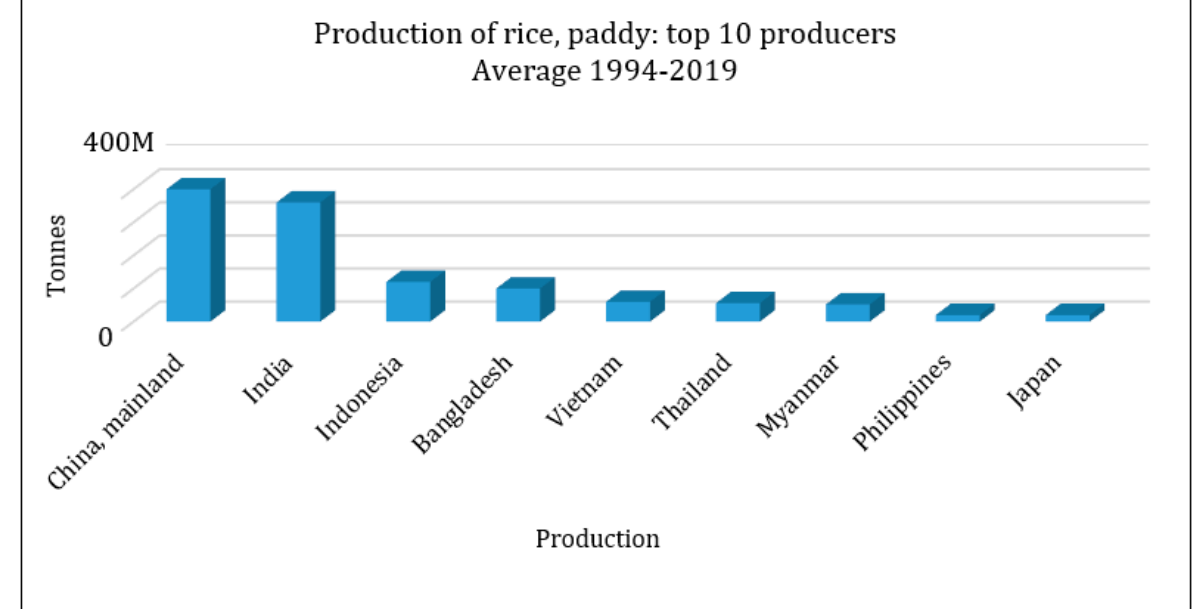
Figure 2. Major rice producing countries (www.fao.org (accessed on 3 March 2022)).